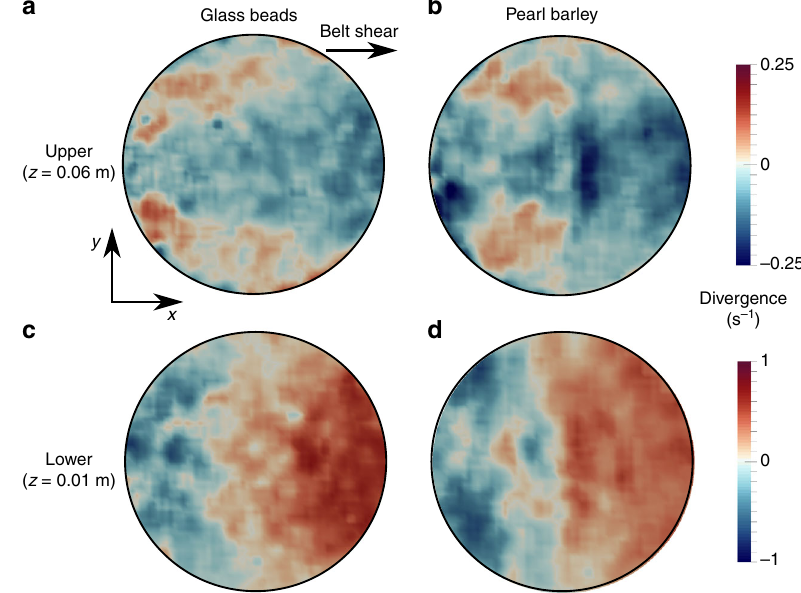
Fig. 6 Divergence fi elds. Intensity maps of the measured divergence fi eld, ∇ ⋅ u , for experiments using glass beads ( a , c ) and pearl barley ( b , d ). Horizontal slices are taken in the upper ( z = 0.06 m, a , b ) and lower ( z = 0.01 m, c , d ) regions of the fl ow